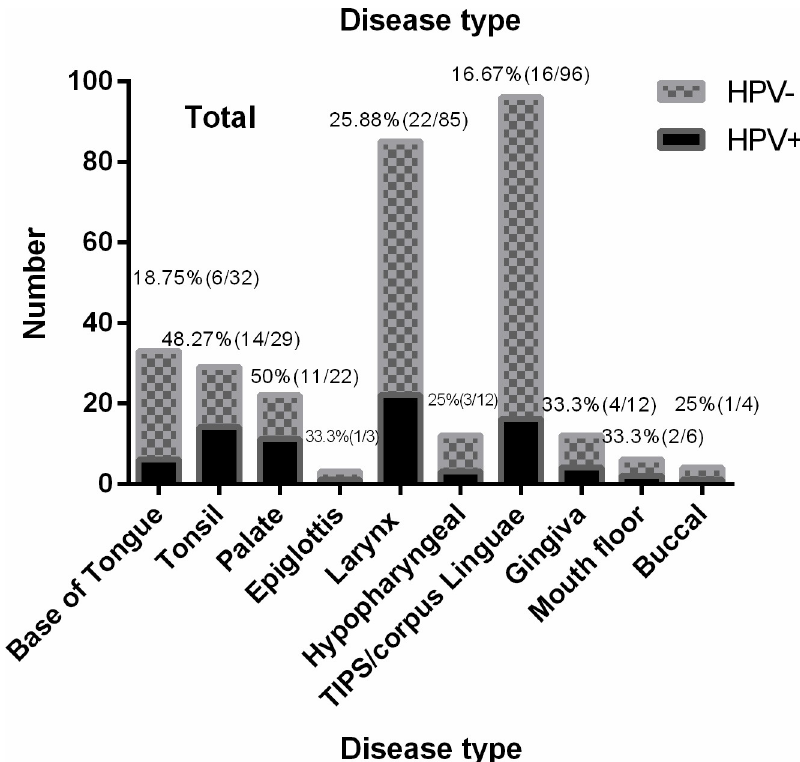
Fig 2. Detection of HPV in HNSCC according to tumour site. For each HNSCC site, the total number of cancers at that site, and the fraction that were HPV+ve, is shown for (a) Guangzhou (b) Foshan (c) Wenzhou and (d) aggregated